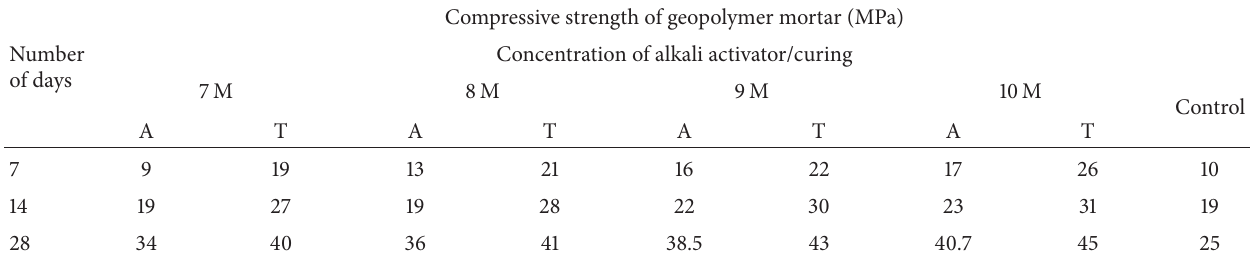
Table 3: 7-, 14-, and 28-day compressive strength of geopolymer and control mortar.